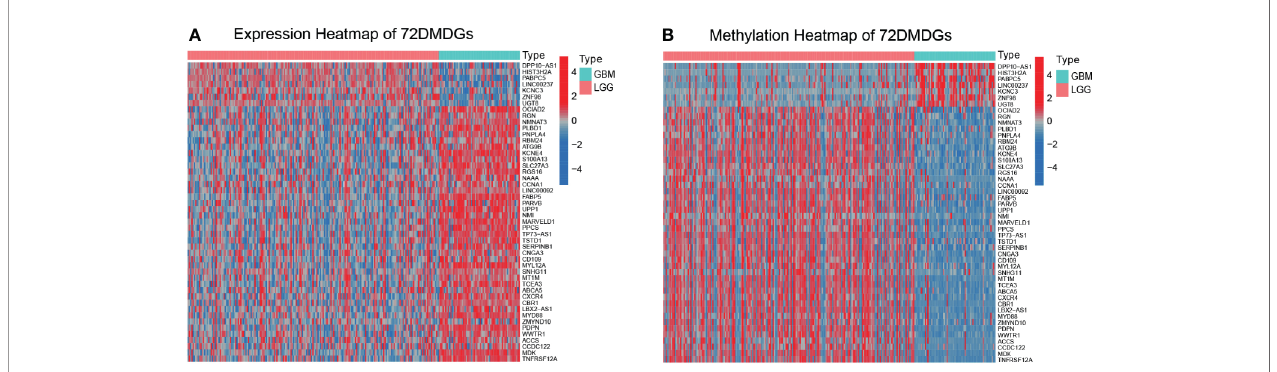
FIGURE 2 | Expression and methylation heatmap of 72 DMDGs in glioma. (A) Expression patterns of 72 DMDGs. Colors from blue to red denote the trend from downregulated to upregulated genes between LGG and GBM tissues. (B) Methylation patterns of 72 DMDGs. Colors from blue to red denote the trend from hypermethylation to hypomethylation between LGG and GBM tissues. DMDGs, DNA methylation-driven genes; LGG, low grade glioma; GBM, glioblastoma multiforme.